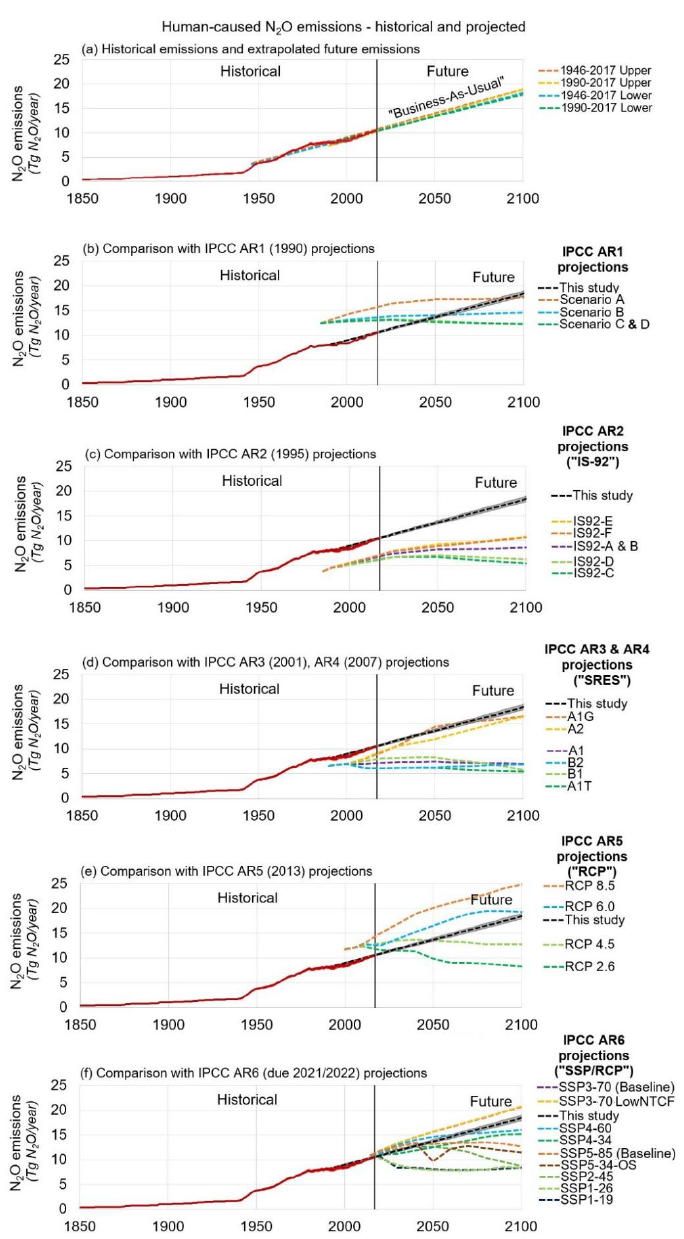
Figure 5. ( a ) Historical and projected “Business-As-Usual” N 2 O emissions. ( b – f ) A comparison of said Business-As-Usual projections to the projections considered by the various IPCC reports. The horizontal axes correspond to years. Details on the projections are provided in Table 2.